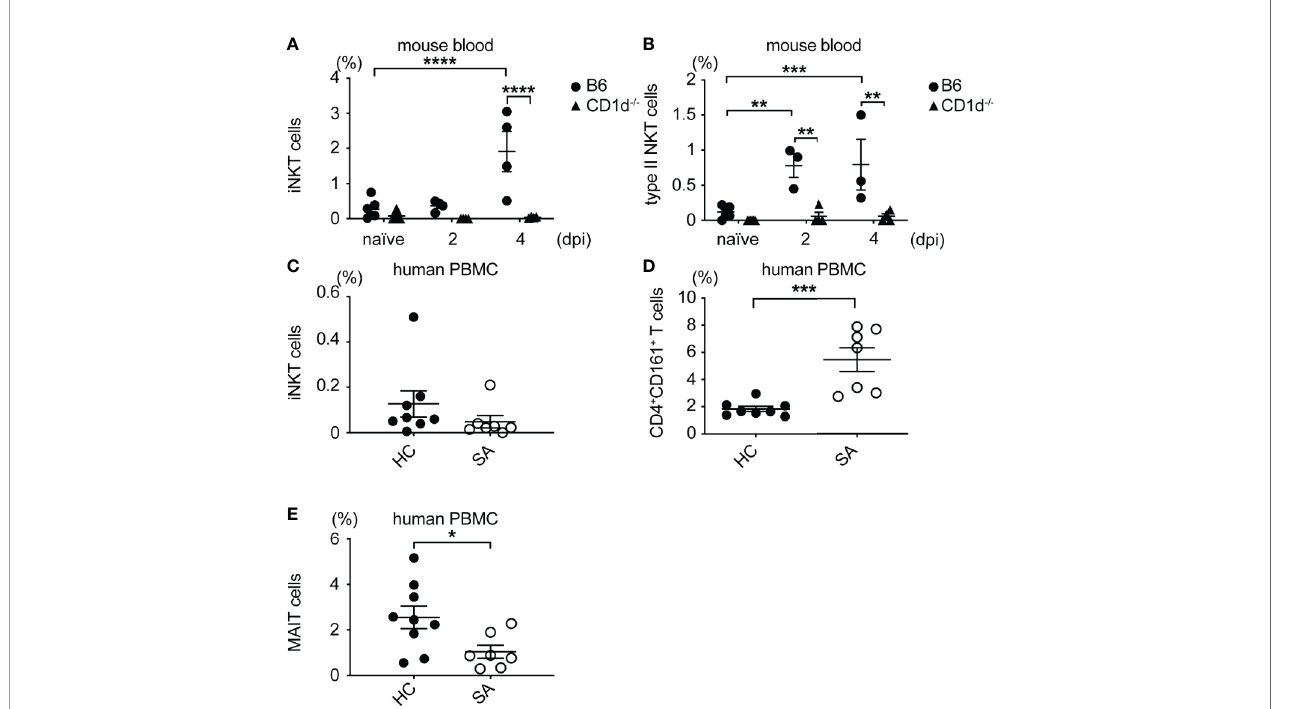
FIGURE 8 | Type II NKT cells expanded in SA bacteremic mice and human patients. (A) Percentage of iNKT cells in blood of B6 and CD1d -/- mice. (B) Percentage of type II NKT cells in blood of B6 and CD1d -/- mice, (A, B) N=7 naïve, three to four infected mice/genotype. (C) Percentage of iNKT cells in SA infected (SA) and healthy control (21) PBMC. (D) Percentage of type II NKT cells in SA and HC PBMC. (E) Percentage of MAIT cells in SA and HC PBMC, (C – E) N=8 – 9 HC, seven SA patients. Statistical analysis: (A – C, E) 2-way ANOVA, (D) student ’ s t-test. *p < 0.05; **p < 0.01; ***p < 0.001; ****p <